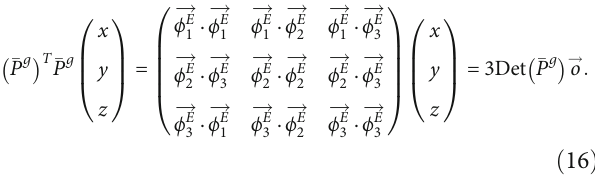
Figure 1: The schematic fi gure of the fl avor triangle and the Earth fl avor triangle